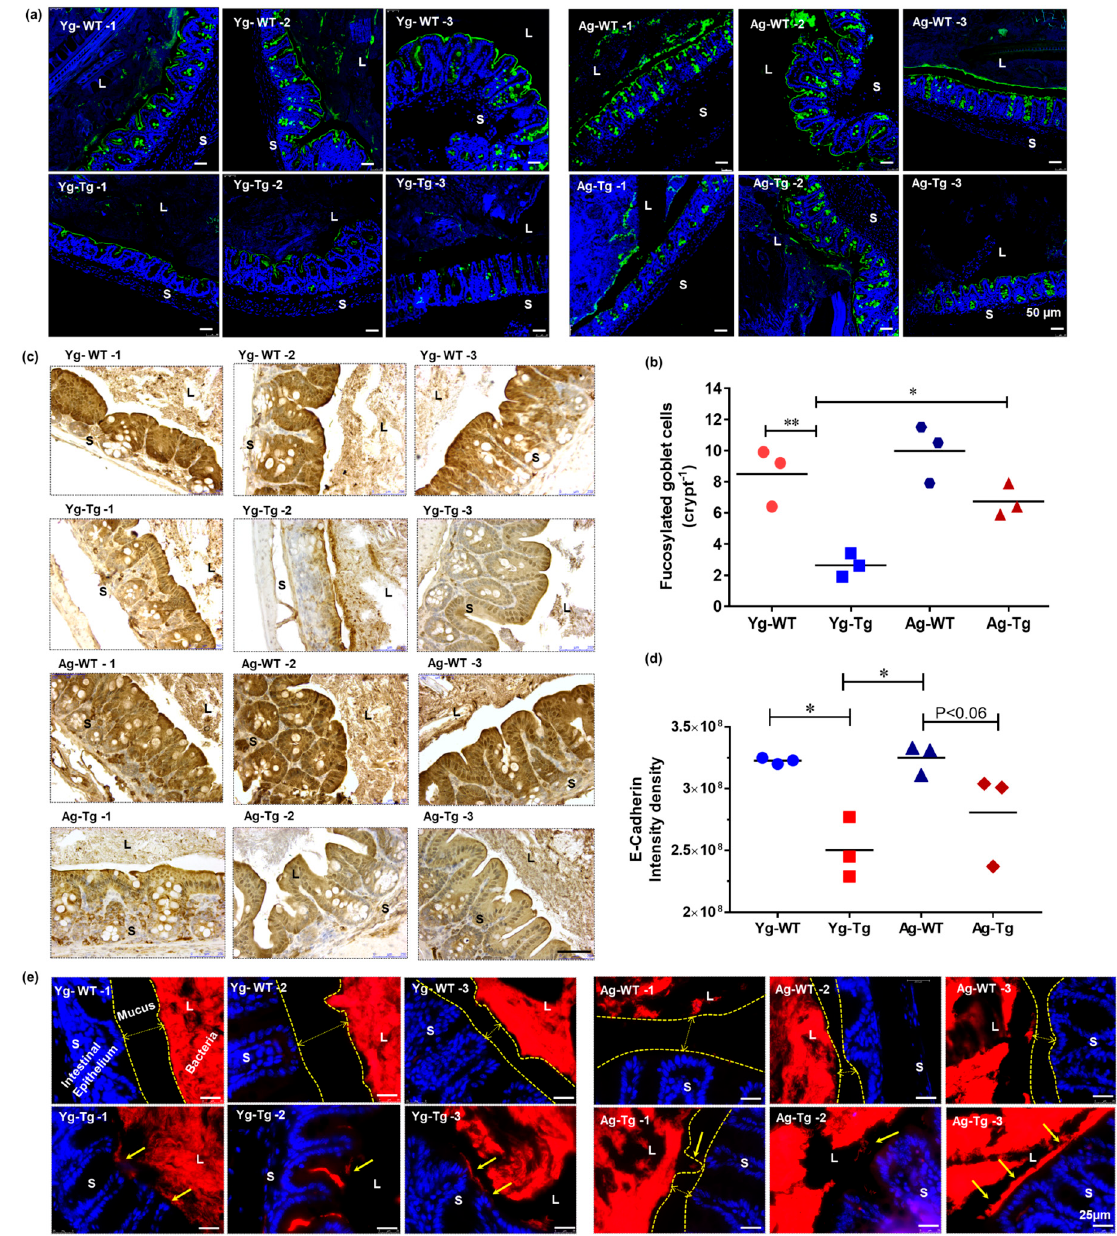
Figure 2. Gut dysfunction occurs before development of A β pathology in the brain in Tg2576 mice. ( a , b ) Lectin staining and mucus fucosylation shows a significant reduction in mucus fucosylation with Ulex europaeus agglutinin staining of the terminal mucus fucose in the cecum of Tg2576 at 6 months when compared to age ‐ matched WT controls. ( c , d ) Immunohistochemical staining of intestinal epithelial shows a significant reduction in E ‐ cadherin expression in Tg2576 mice when compared to